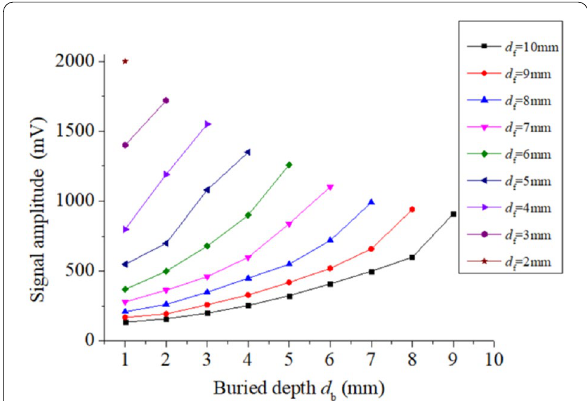
Figure 15 The V pm of the nine inner defects with the same fixed distance d f